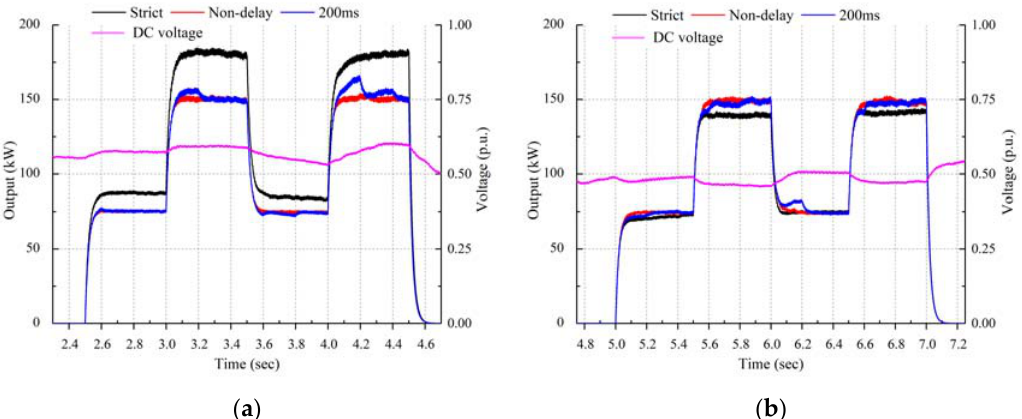
Figure 9. ESS states for multistring topology with 100 ms interval ( a ) extracted power quantity in the discharging section (2.5 to 4.5 s); ( b ) absorbed power quantity in the charging section (5 to 7 s).